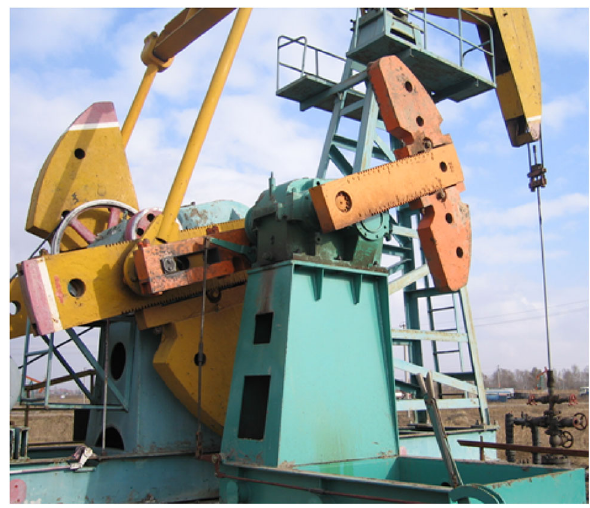
Fig. 12 Secondary balance device (Feng et al. 2015)